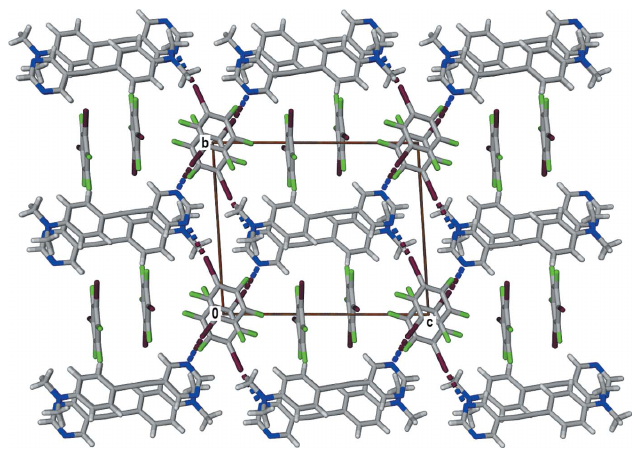
Figure 4 View of crystal packing of the title compound viewed along the a- axis